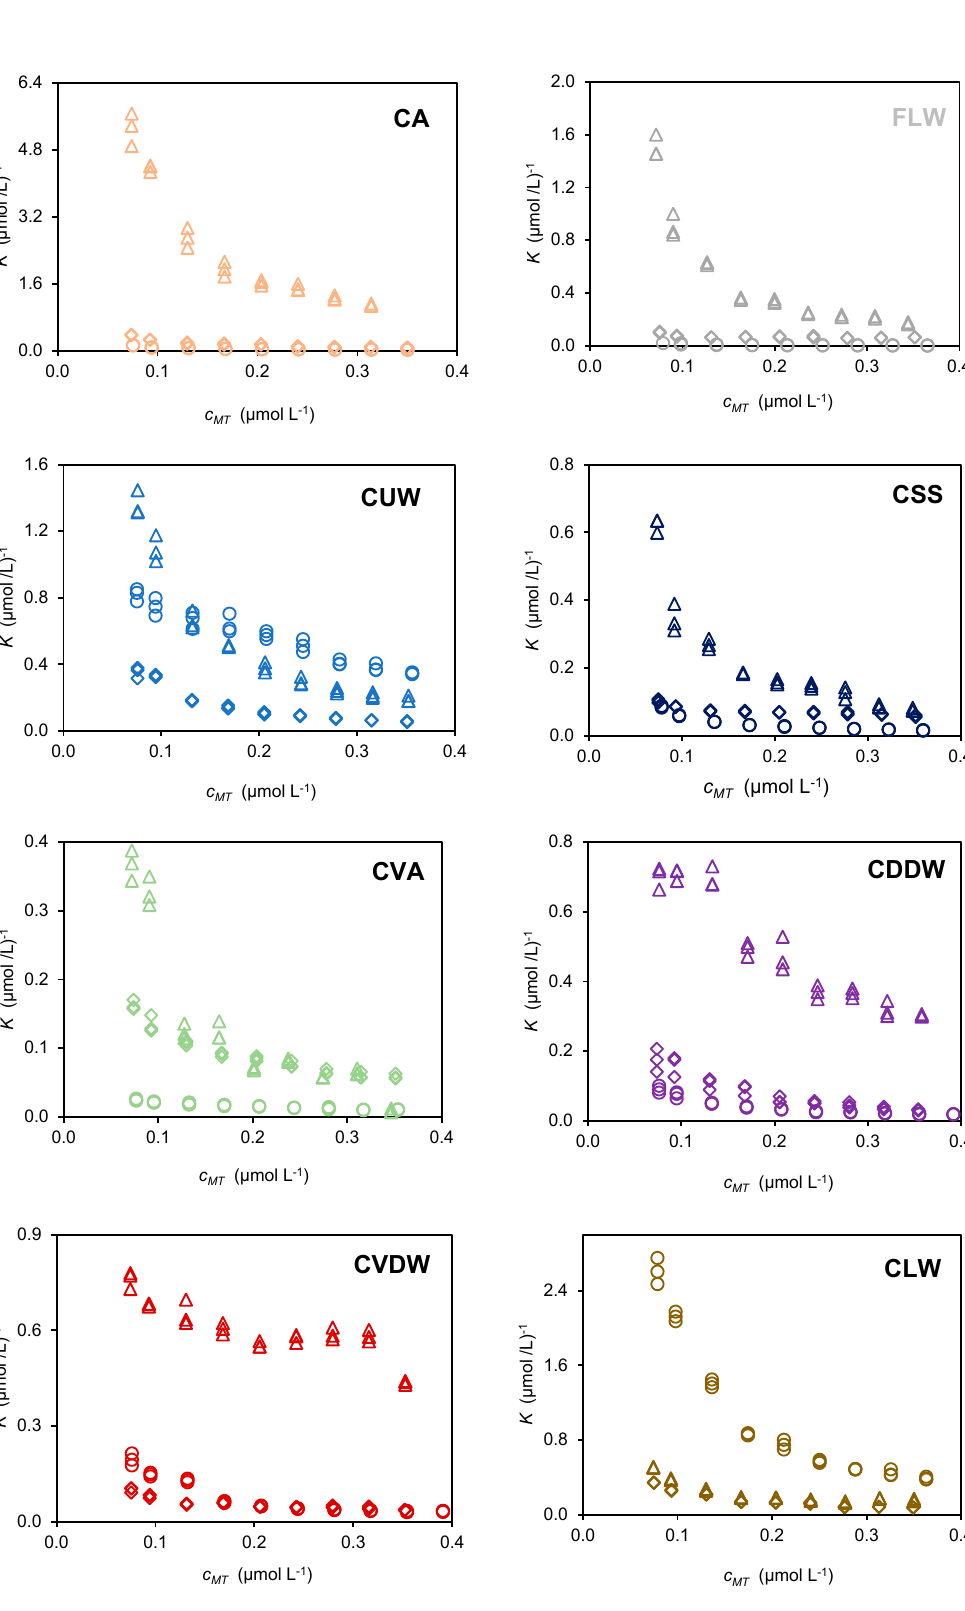
Figure 1. Experimental data expressed as complexation ratio, K , as a function of the total Cd 2+ concentration, c MT at pH 7.0 and ionic strength 12 mmol L − 1 for FA ( ♦ ), HA ( ∆ ), and DOM (o) extracted from 7 different composts (CA, CUW, CSS, CVA, CDDW, CVDW, and CLW) and one fertiliser (FLW).